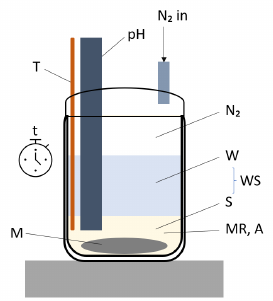
Figure 25. Setup used for the synthesis of hydrocalumite.